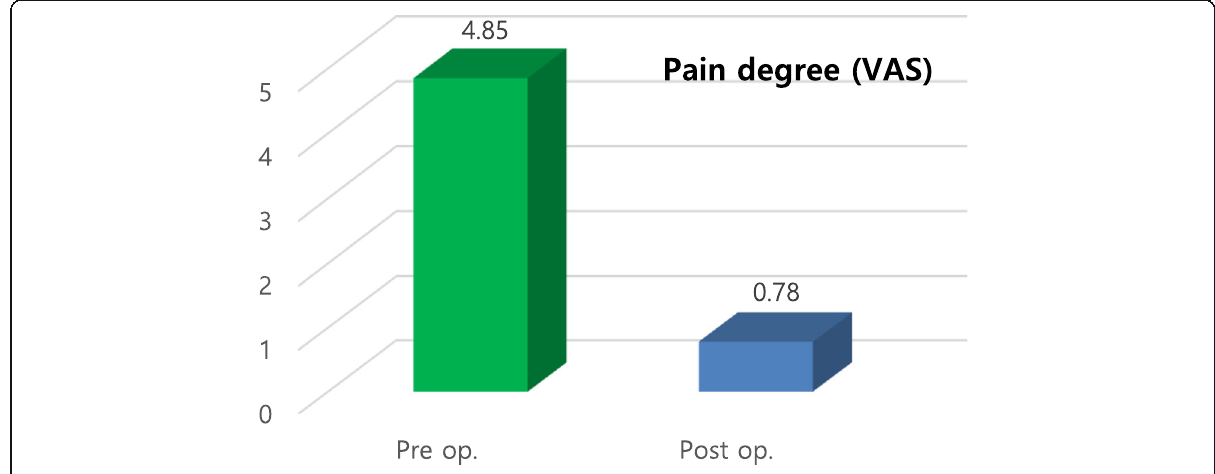
Fig. 11 Evaluation of preoperative (Pre op.) and postoperative (Post op.) pain degree